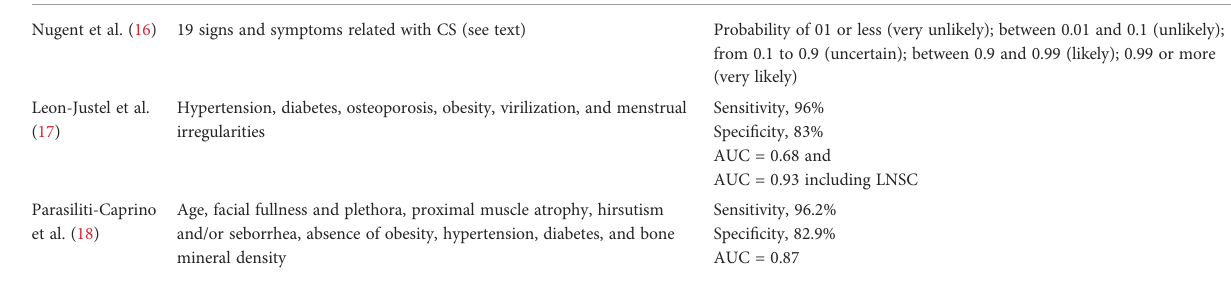
TABLE 2 Cushing syndrome clinical risk